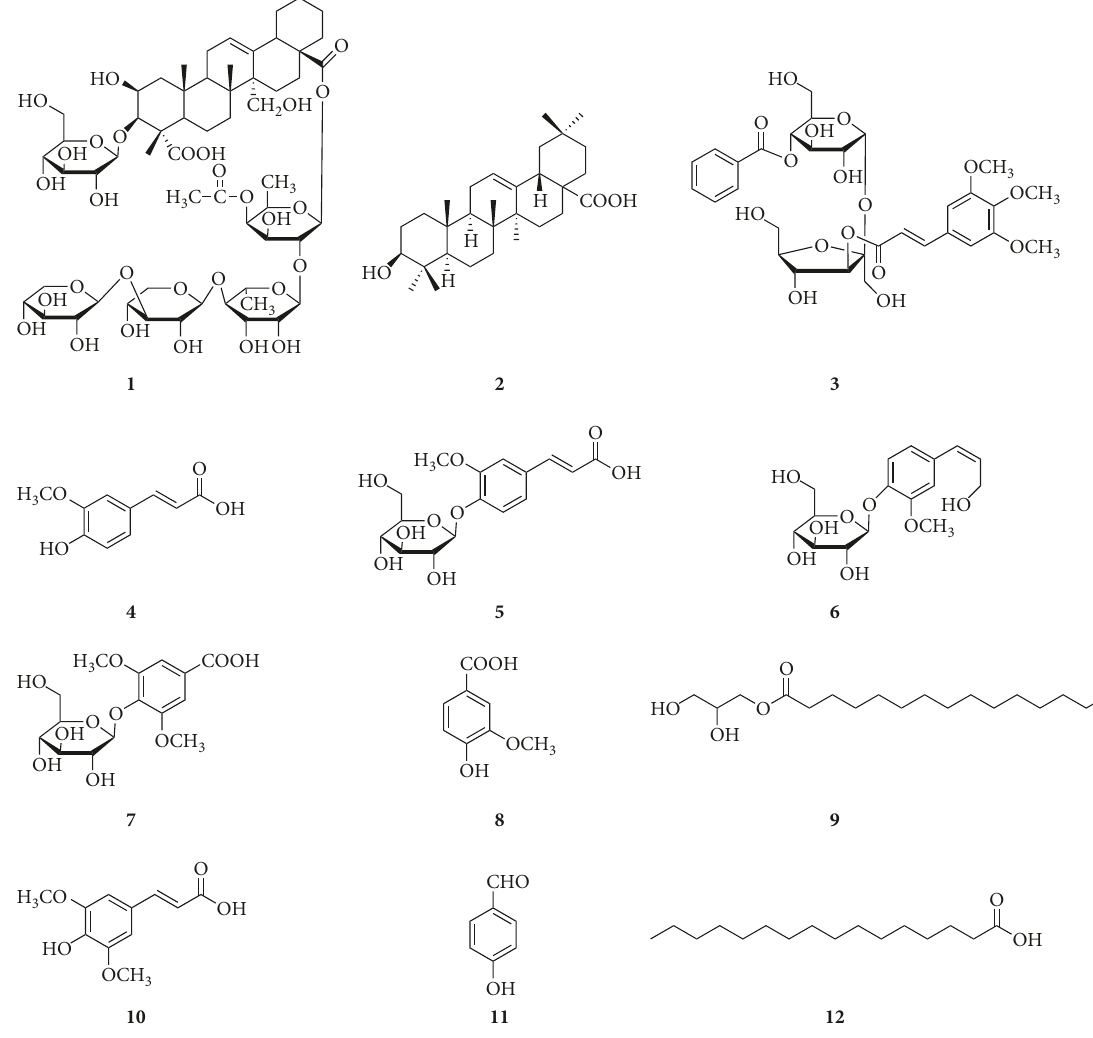
Figure 1: Chemical structures of compounds 1 – 12